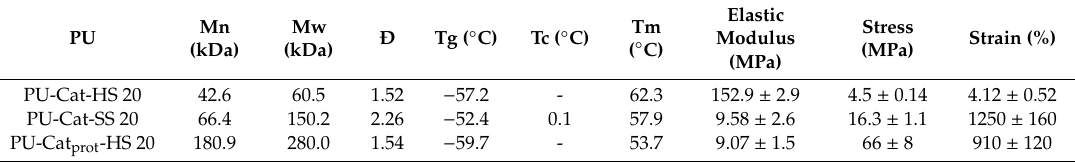
Table 2. GPC measurements, thermal characterization and mechanical properties of PU-Cat-HS 20, PU-Cat-SS 20, and PU-Cat Prot -HS 20.